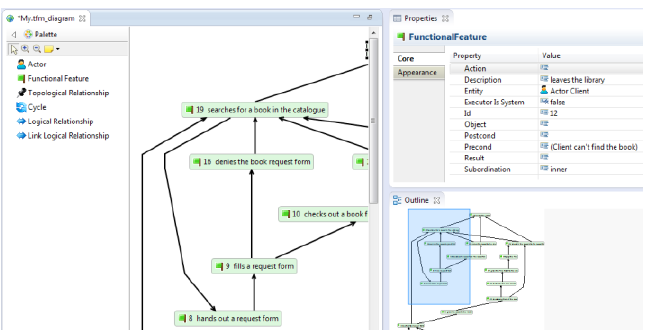
Fig. 4. TFM Diagram Tool. On the left-hand side there is a palette with the available objects for the diagram. In the middle there is a canvas with the diagram itself, and on the right-hand side there is a property pane and an outline view.